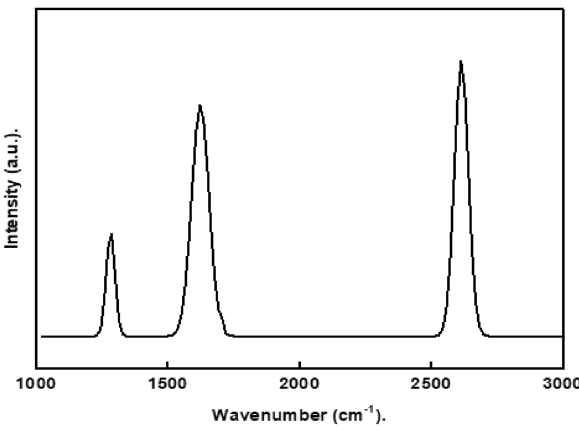
Figure 1. Raman spectra of the prepared